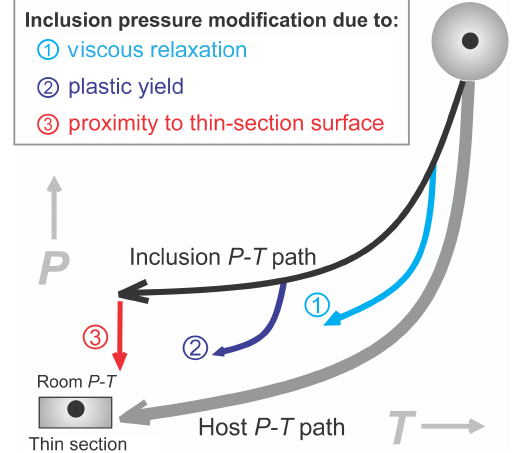
Figure 1. Schematic illustration for the residual pressure. The grey and black curves are retrograde P – T paths for host and inclu- sion, respectively. Pressure drop is possibly due to the follow- ing reasons: (1) viscous relaxation preferentially occurs at high- temperature conditions; (2) plastic yield commonly occurs at low confining pressures where residual pressure is high; (3) thin-section preparation that drives inclusion close to the thin-section surface. Note that this illustration refers to systems where the inclusion is elastically softer than its host (e.g. quartz in